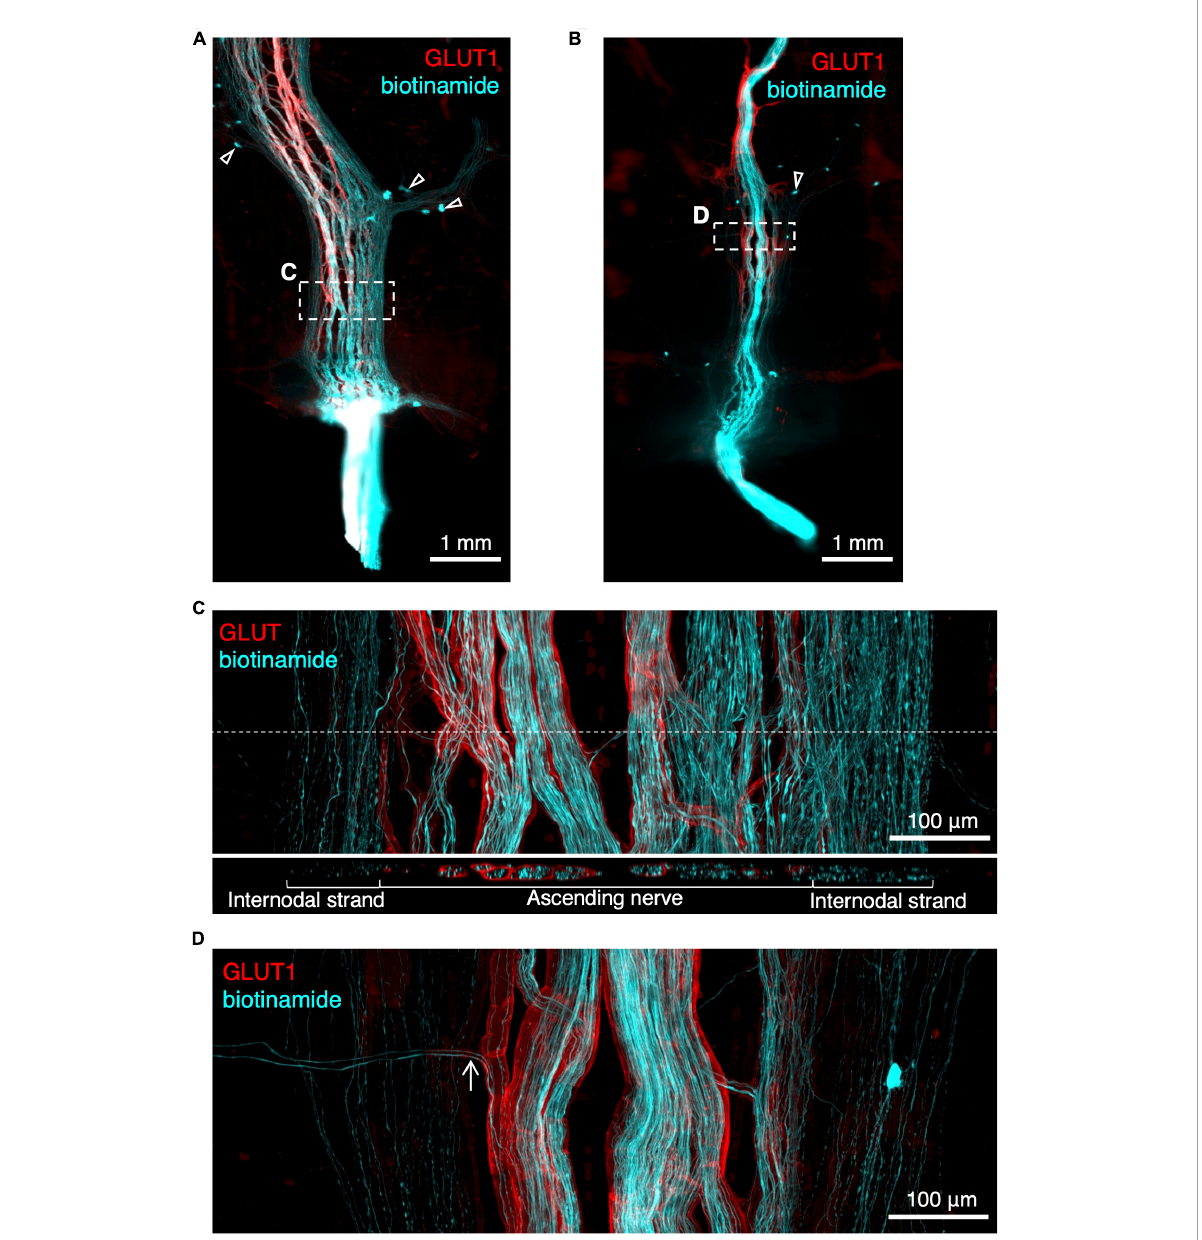
FIGURE5 Rapid anterograde tracing of ascending nerves with biotinamide (cyan) combined with glucose transporter 1 (GLUT1) immunoreactivity (red). An ascending nerve was dissected free for ∼ 5 mm at the aboral end of a segment of colon and labelled with biotinamide (see section “Materials and methods”). As expected, axons running within a GLUT1 immunoreactive sheath were labelled. Panel (A,B) show biotinamide fills at low power. Note numerous small biotinamide-labelled myenteric nerve cell bodies (open arrowheads); these are likely to have been filled from nearby internodal strands of the myenteric plexus. Attempts to dissect away internodal strands prior to filling (B) were only partially successful. Panel (C) shows a detailed region from panel (A) (dashed outlines) with GLUT1 labelled ascending nerve and parallel internodal strands on either side. An X–Z virtual section (at the level of the dashed line) shows GLUT1 sheaths surrounding strands of the ascending nerve but not internodal strands. Panel (D) shows two biotinamide-filled axons (arrow) leaving an ascending nerve to join nearby myenteric plexus [dashed outline in panel (B)